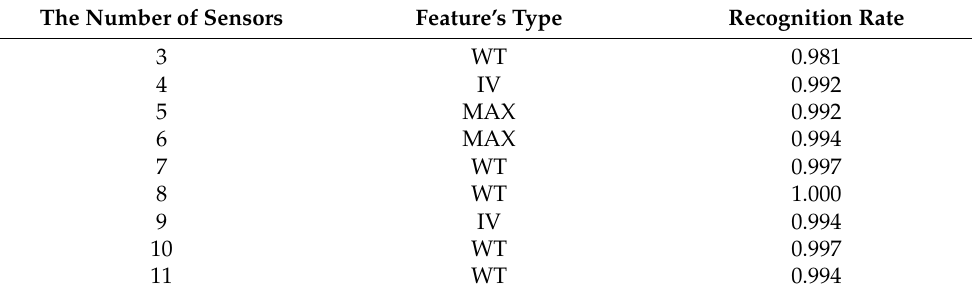
Table 7. Classification accuracy of the sensor subset RF model test